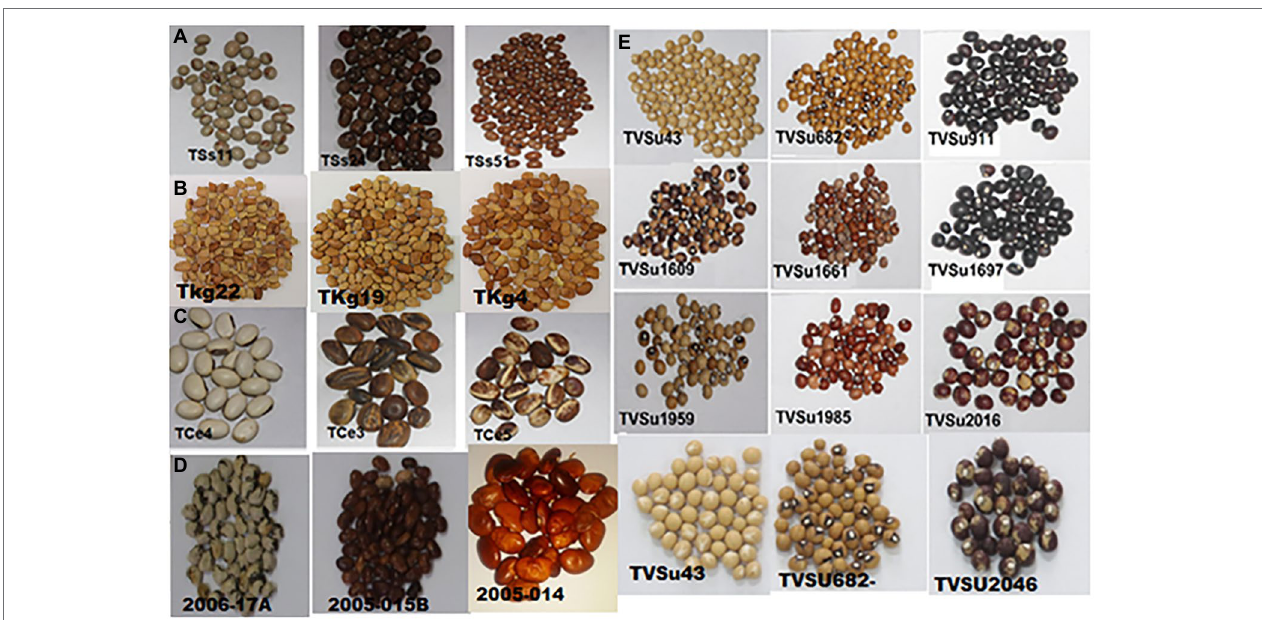
FIGURE 3 | Diversity in seeds of the selected orphan legume crops. (A) African yam bean ( Sphenostylis stenocarpa ). (B) Kersting’s groundnut ( Macrotyloma geocarpum ). (C) Jack bean ( Canavalia ensiformis ). (D) Lima bean ( Phaseolus lunatus ). (E) Bambara groundnut ( Vigna subterranean ). Source: seeds were collected from the International Institute of Tropical Agriculture (IITA, Ibadan,